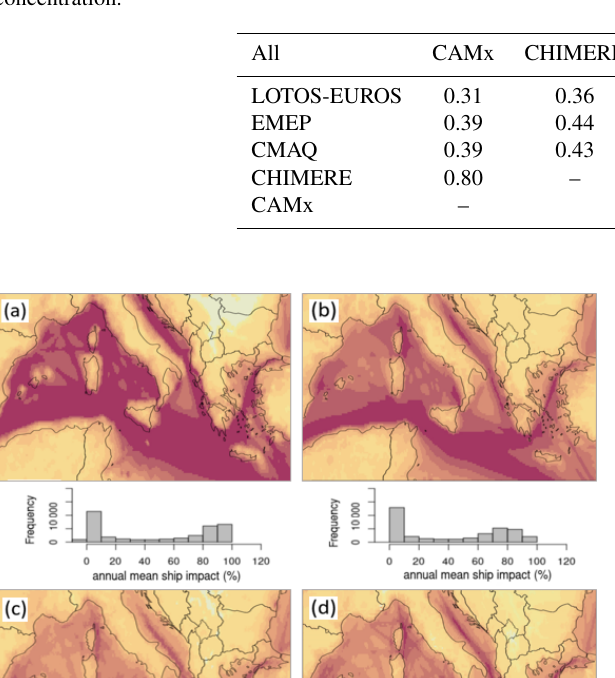
Table 4. Correlation for the NO 2 base run between models for the whole domain (all grid cells), based on hourly data for NO 2 total concentration.